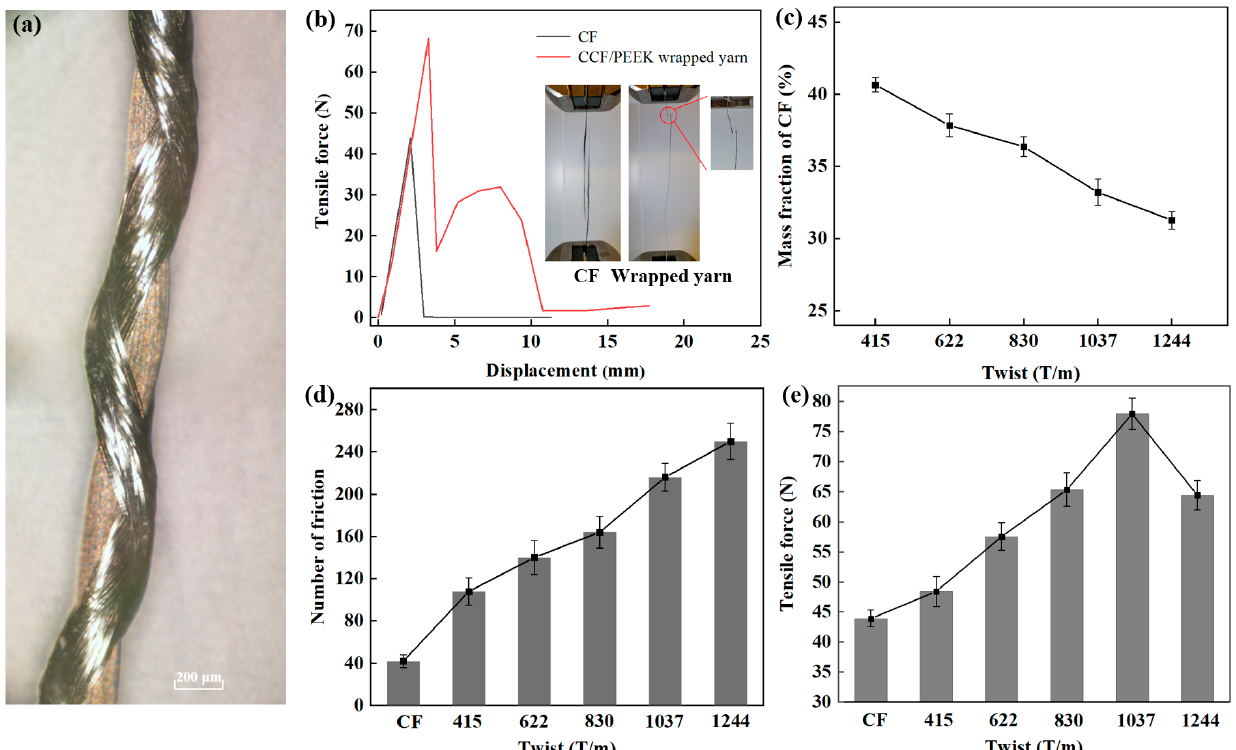
Figure 3. ( a ) Morphology of CCF/PEEK wrapped yarn. ( b ) Tensile curves of CCF/PEEK wrapped yarn and CF. Inset: pictures of tensile tests. ( c ) Mass fraction of CF in wrapped yarn with different twists. ( d ) Friction properties of CF and wrapped yarn with different twists. ( e ) Tensile strength of wrapped yarn with different